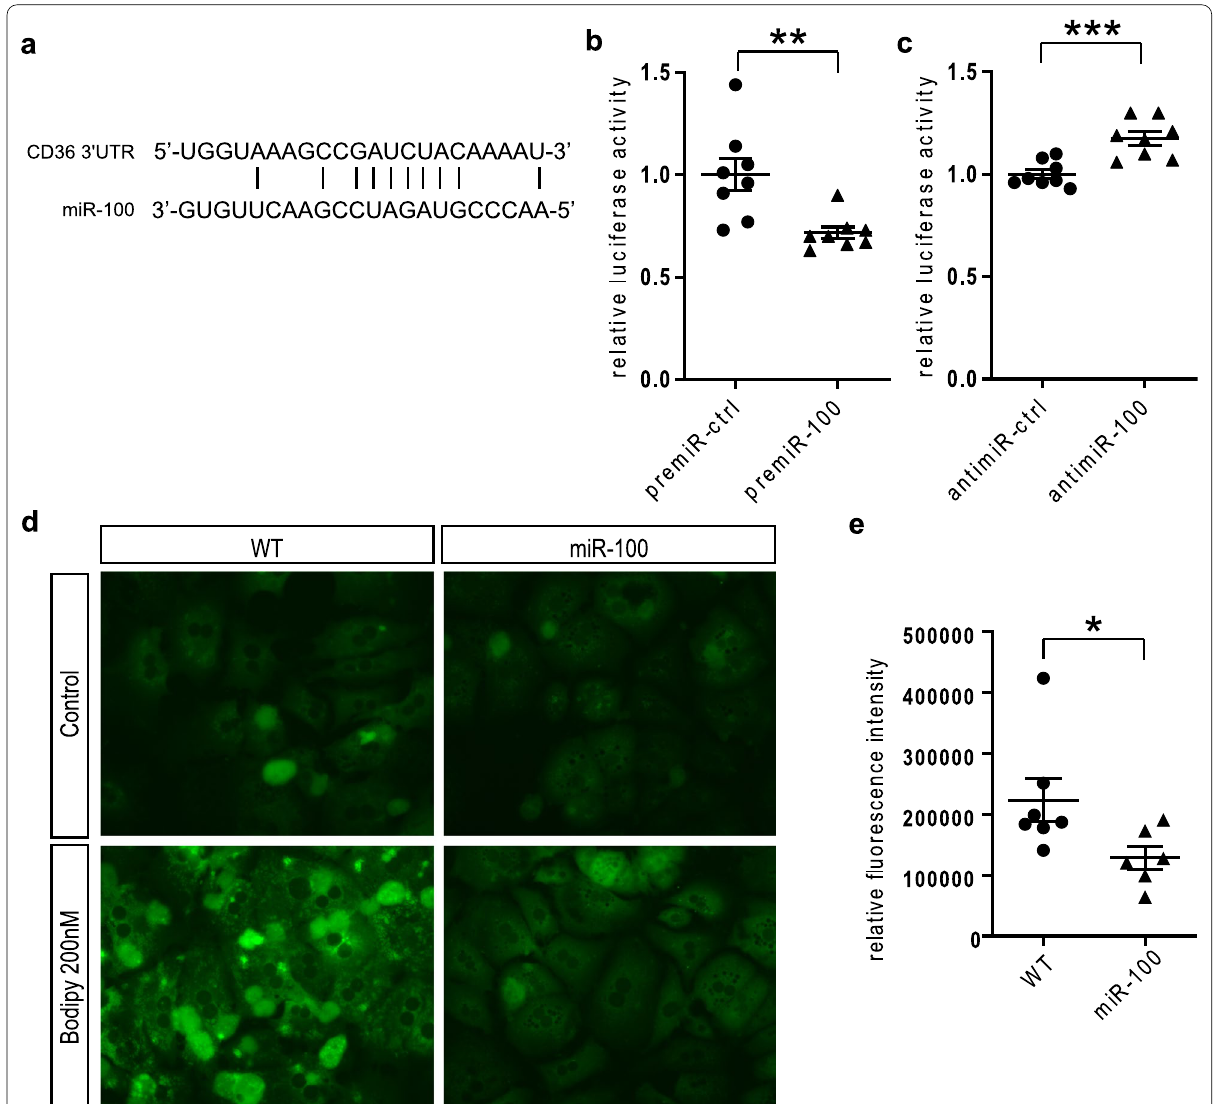
Fig. 6 MiR-100 overexpression attenuates lipid accumulation in primary cultured hepatocytes. a The illustration shows the potential binding site of miR-100 in the 3 ′ UTR of CD36. b The luciferase activity was reduced when the CD36 3 ′ UTR plasmid and miR-100 precurser molecules (premiR-100) were overexpressed (n 8). c The luciferase activity was induced when the CD36 3’UTR plasmid was overexpressed together with the miR-100 = inhibitory molecule antimiR-100 (n 8). d Exemplary fluorescence images of BODIPY FL C16 uptake in primary cultured mouse hepatocytes = isolated from wildtype and miR-100 overexpressing mice are shown (Magnification: 400). The hepatocytes were treated with DMSO control × or BODIPY FL C16 at 200 nM for 1 h. e The quantification of BODIPY FL C16 revealed a reduced uptake into hepatocytes isolated from miR-100 overexpressing mice. (n 6–7) Data represent mean values with SEM. *P < 0.05, **P < 0.01 and ***P < 0.001 vs. the corresponding =